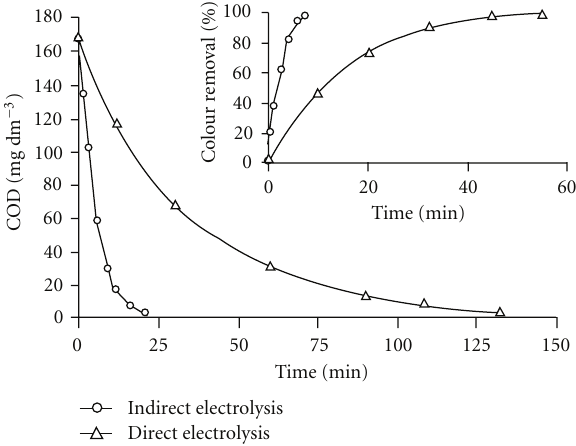
Figure 4: Comparison of the COD evolution and colour removal (inset) during the direct and mediated electrolysis of the methylene blue. Indirect electrolysis: Cl − concentration = 1.2 gdm − 3 ; i = 60mAcm − 2 ; flow rate: 180dm 3 h − 1 ; T = 40 ◦ C. Direct electrolysis: i = 20 mAcm − 2 ; flow rate: 180 dm 3 h − 1 , T = 40 ◦ C